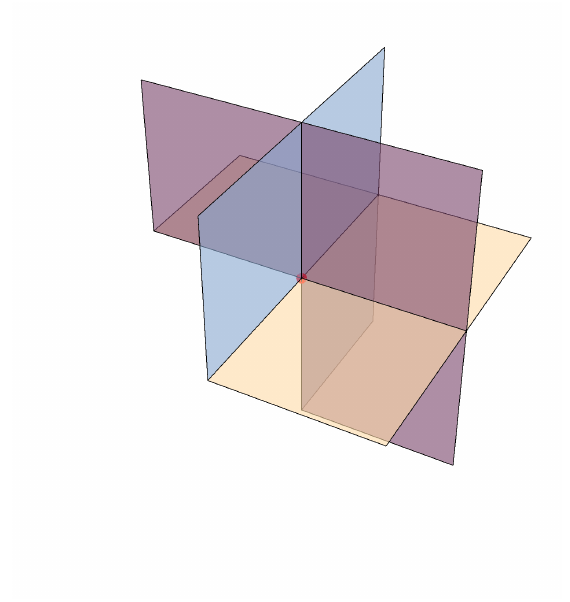
Figure 3: An example of a possible configuration of domain walls around a